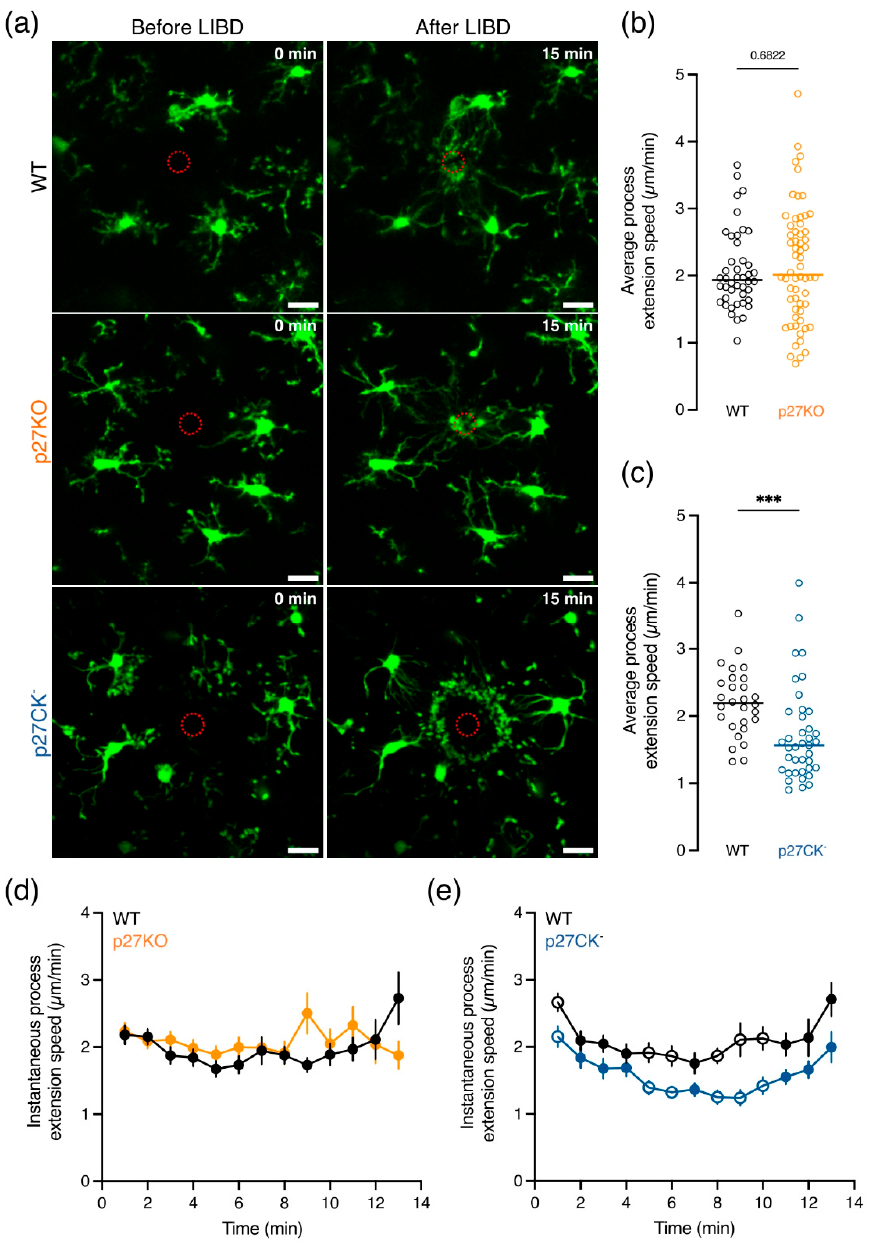
Figure 5. Process extension speed is decreased in microglia expressing a cell cycle dead variant of p27. ( a ) Representative images showing cortical microglia ex vivo rapidly responding towards laser-induced brain damage (LIBD). Scale bar = 20 µm. ( b , c ) The average process extension speed did not differ between p27WT and p27KO ( b ) microglia while p27CK − ( c ) microglia displayed a slower process extension speed compared to p27WT cells. ( d , e ) The instantaneous velocity as a function of time shows no speed differences between p27KO ( d ) and p27WT microglia but a decreased speed upon a cell cycle dead variant of p27 (p27CK − ) ( e ). Sample size ( b ) for p27WT 44/6/3 (cells/brains/mothers); p27KO 60/5/3. Sample size ( c ) for p27WT 28/3/3; p27CK − 39/3/3. Data points in b and c represent individual microglia and the horizontal bars represent the median. *** p < 0.001. Empty data points (in ( d , e )) represent significant differences ( p < 0.001), and values are reported as mean ± SEM. Mann–Whitney U test.